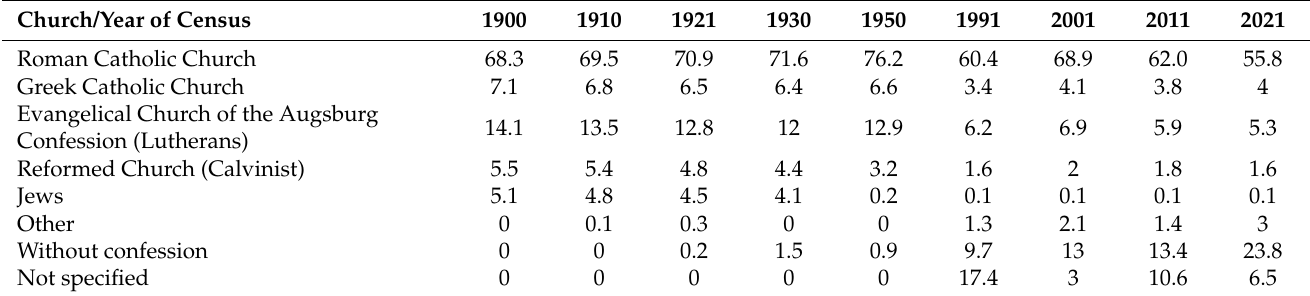
Table 1. Population in Slovakia by main confessions in censuses 1900–2021 (in %).